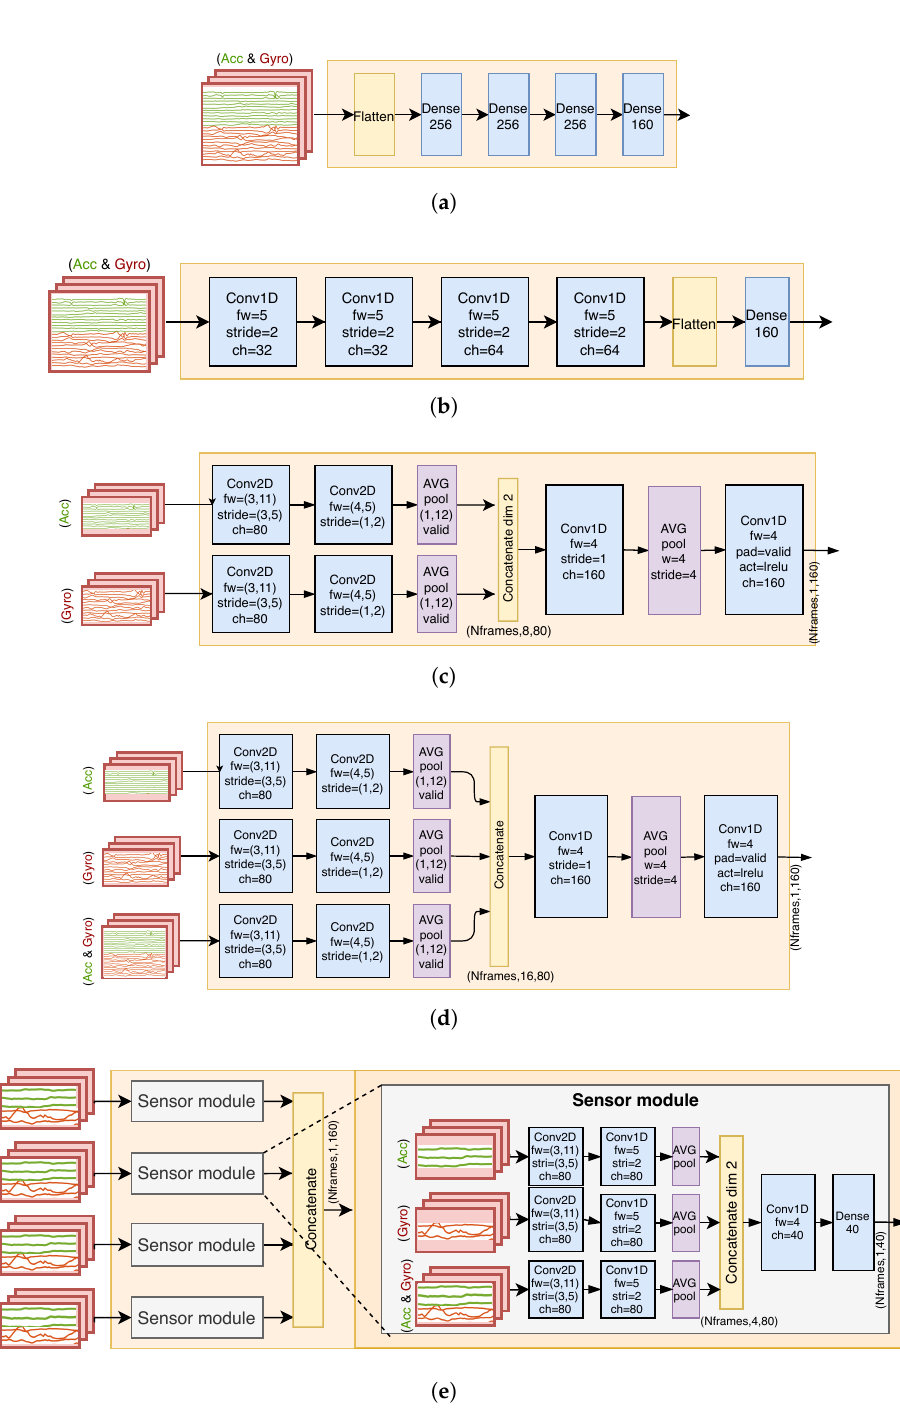
Figure 3. Compared encoder module architectures. ( a ) Dense encoder; ( b ) 1-D CNN (Conv1D) encoder; ( c ) 2-D CNN with individual paths (Conv2D-I) encoder; ( d ) 2-D CNN with individual and shared paths (Conv2D-IS) encoder; ( e ) 2-D CNN with sensor-independent modules (Conv2D- SI)